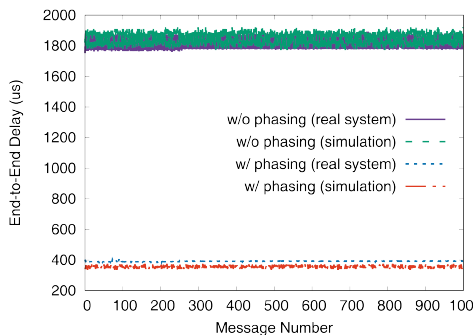
Figure 18. D e 2 e distribution of VC 1 in test set